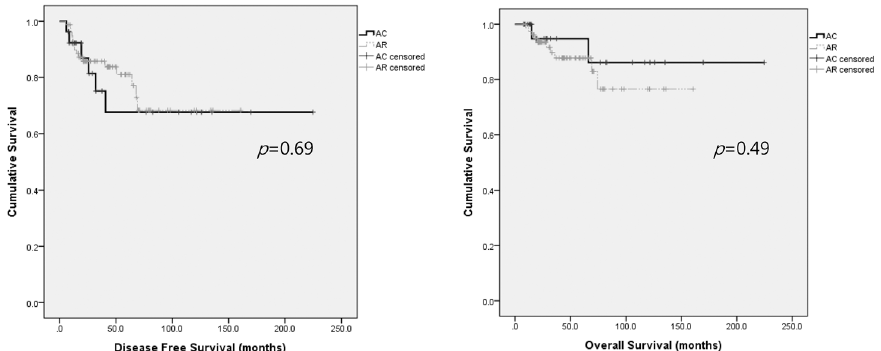
Fig 2. In the nodal metastasis subgroup, Kaplan-Meier survival curves also indicated no significant differences in progression-free survival or overall survival between patients radiotherapy or concurrent chemoradiation therapy (AR, n = 80) ( p = 0.69 and 0.49, respectively). AC: adjuvant chemotherapy; AR: adjuvant radiotherapy of concurrent chemoradiation.